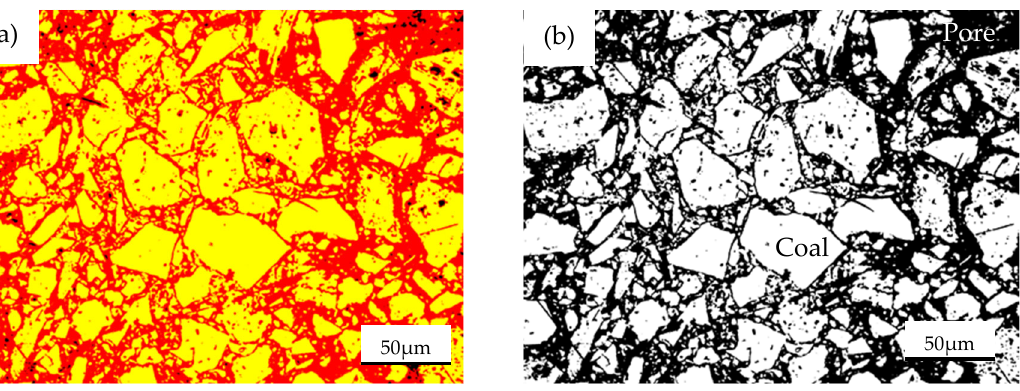
Figure 3. Image and binary image of filter cake under polarizing microscope. ( a ) The image of filter cake; ( b ) the binary image of filter cake.